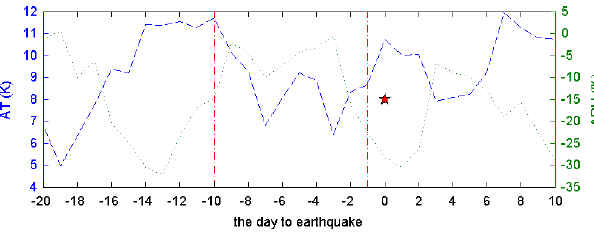
Fig. 9. The difference between the basin point (30 ◦ N,105 ◦ E) and the mountain point (30 ◦ N, 102.5 ◦ E) in air temperature and relative humidity (red star points to the day in which earthquake